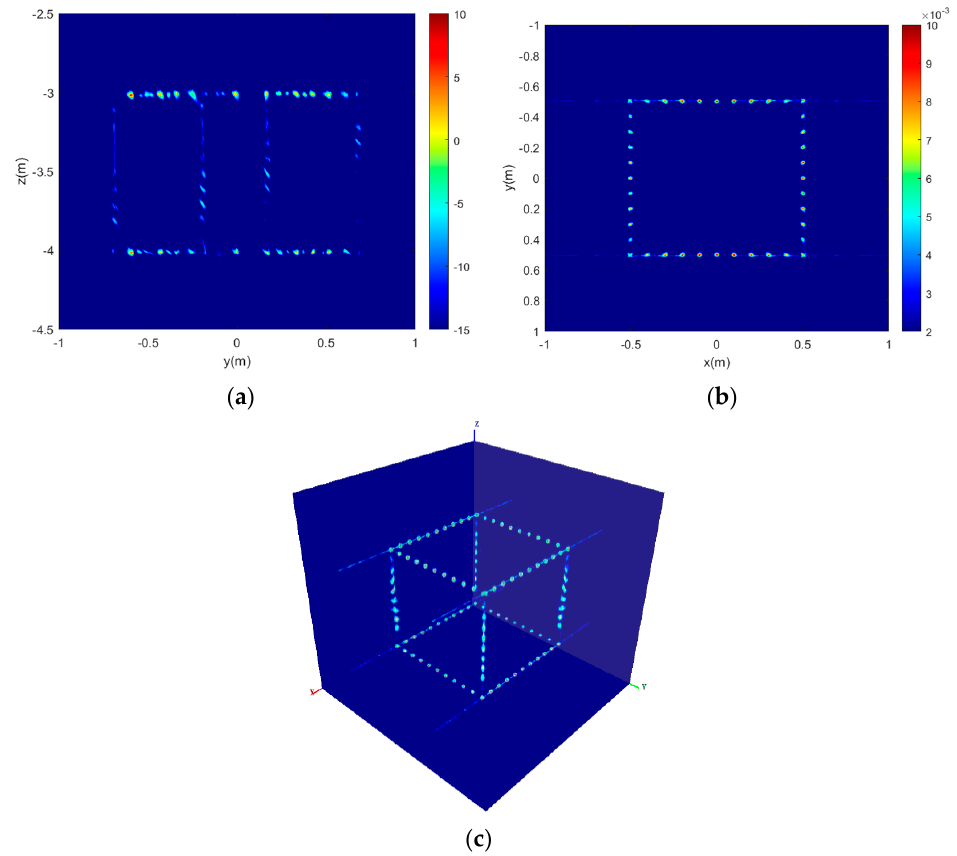
Figure 7. The 3D imaging simulation results of circular array synthetic aperture sonar. ( a ) the reconstruction in the height direction at angle 15 ◦ ; ( b ) the 2D imaging result of horizontal slice at height z = − 4; and ( c ) the 3D imaging result of the simulated